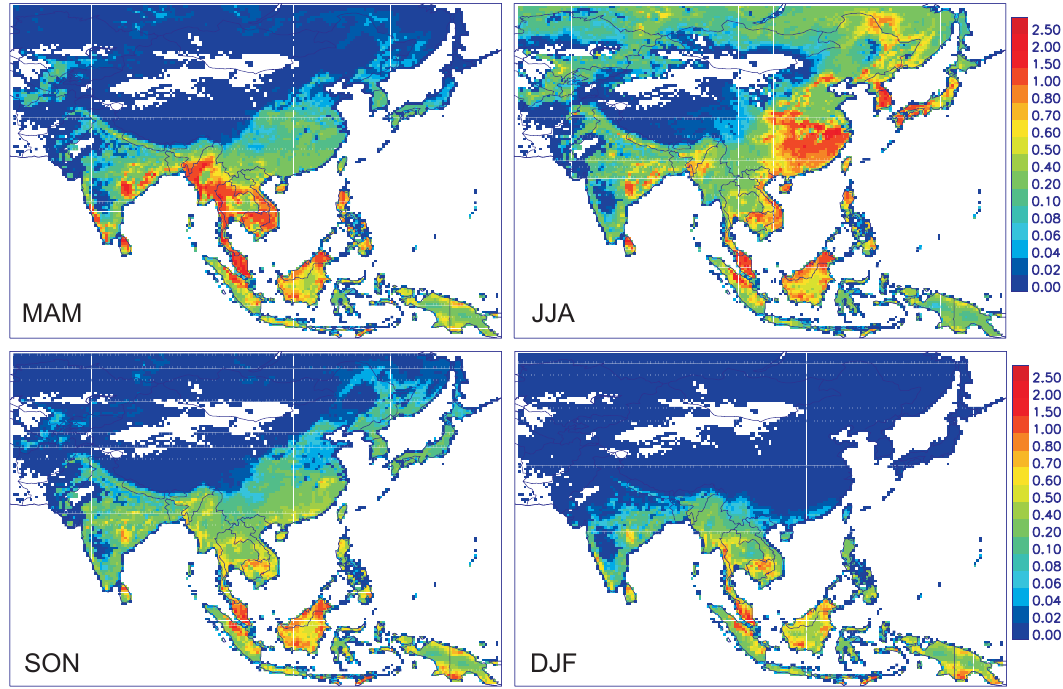
Fig. 9. Seasonal isoprene emission rates calculated by the S4 simulation in 2005 expressed in mg isoprene m − 2 h − 1 in March-April-May (MAM), June-July-August (JJA), September-October-November (SON), and December-January-February (DJF).